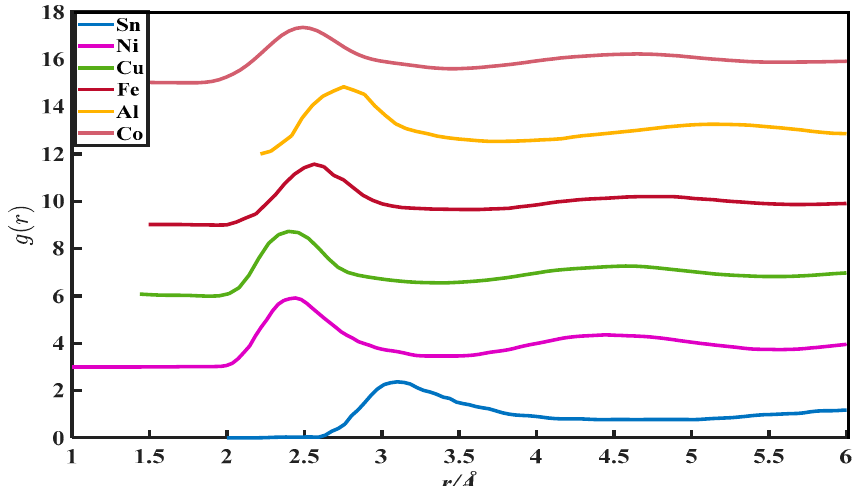
Figure 4. The pair distribution function of Sn, Ni, Cu, Fe, Al, and Co.